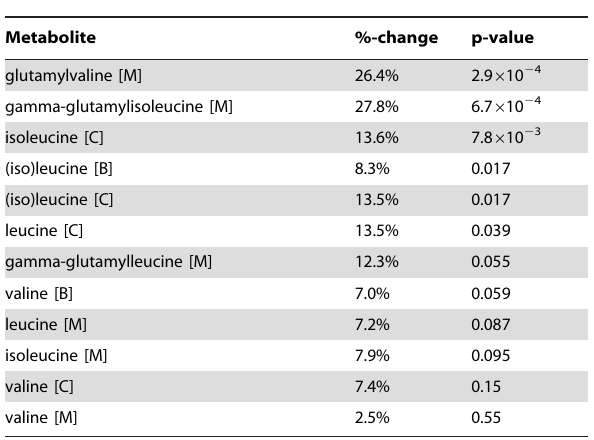
Table 5. Difference of average branched chain amino acids (BCAA) concentrations between the diabetes and the control group; a positive value %-change indicates higher concentrations in the diabetes group; where metabolites that were measured on more than one platform, results from these platforms are presented